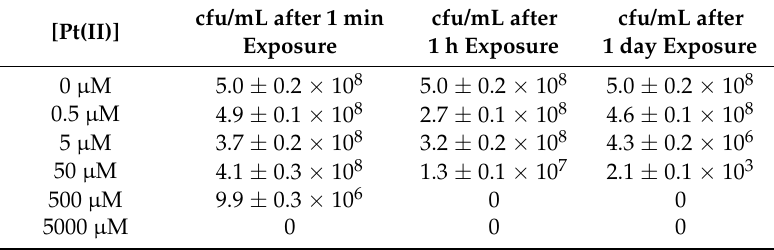
Table 1. Toxicity study where C. metallidurans was reacted with aqueous Pt(II).